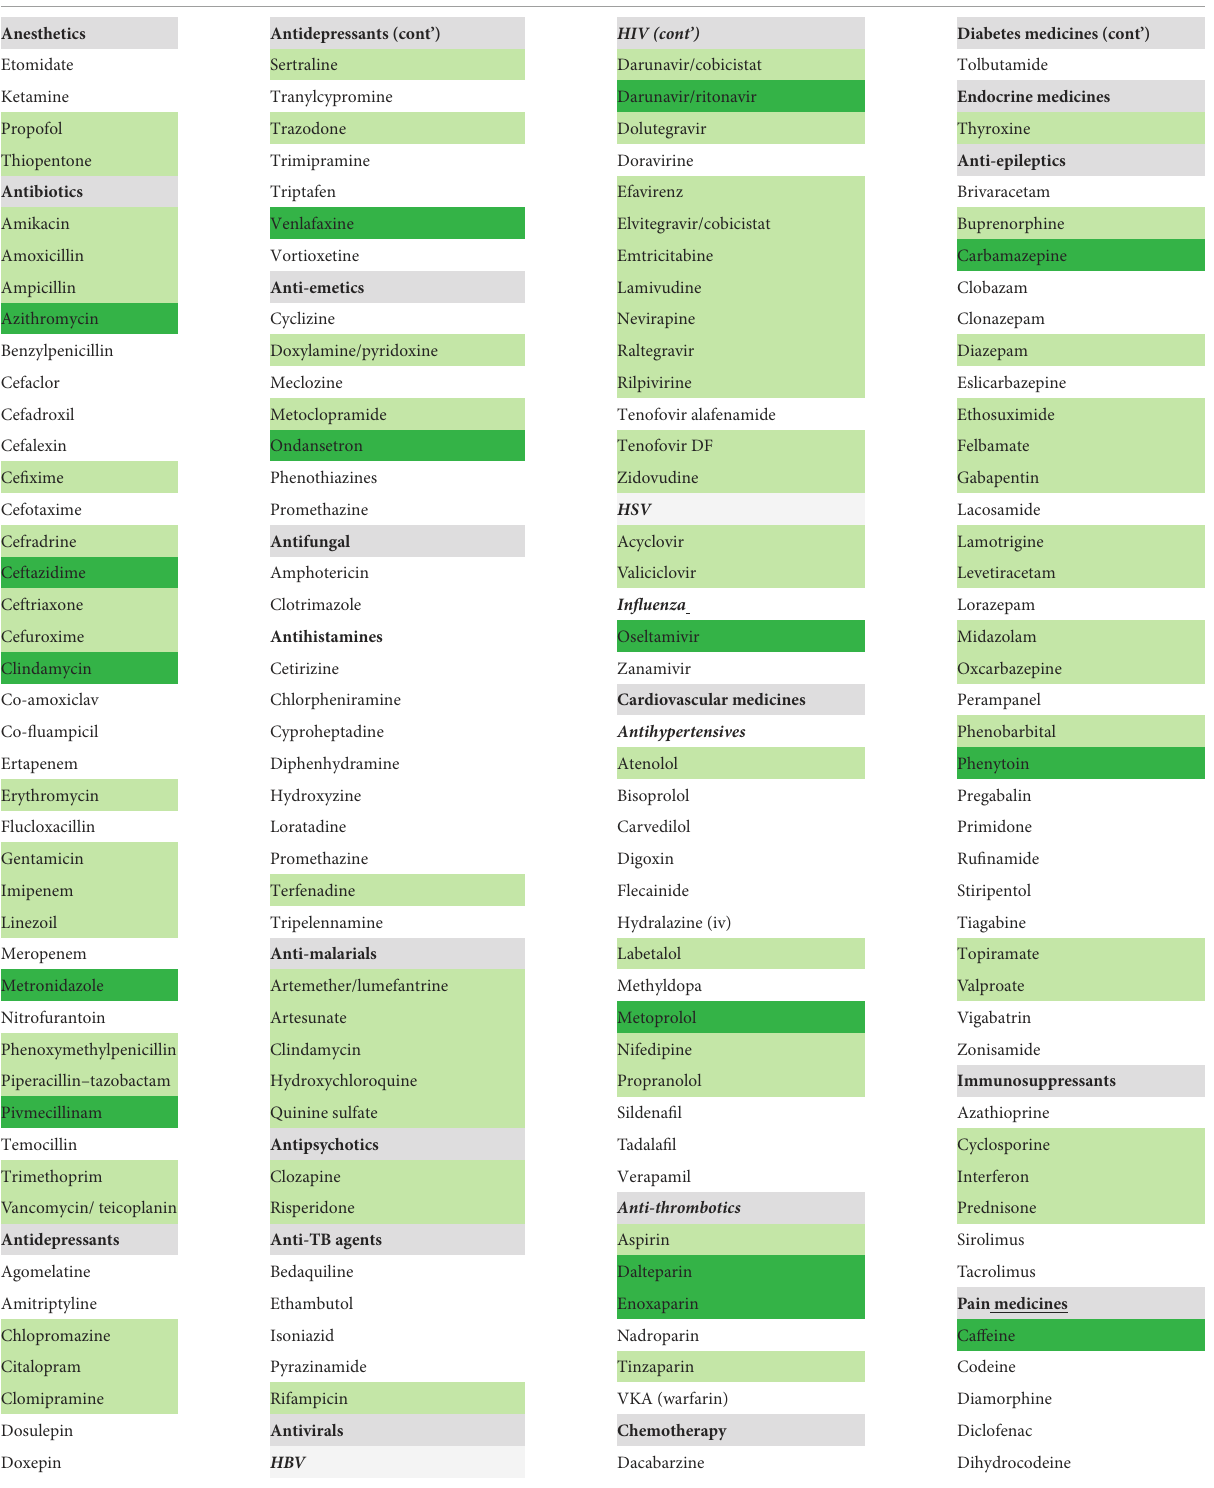
TABLE 1 List of medicines commonly used in pregnancy in the